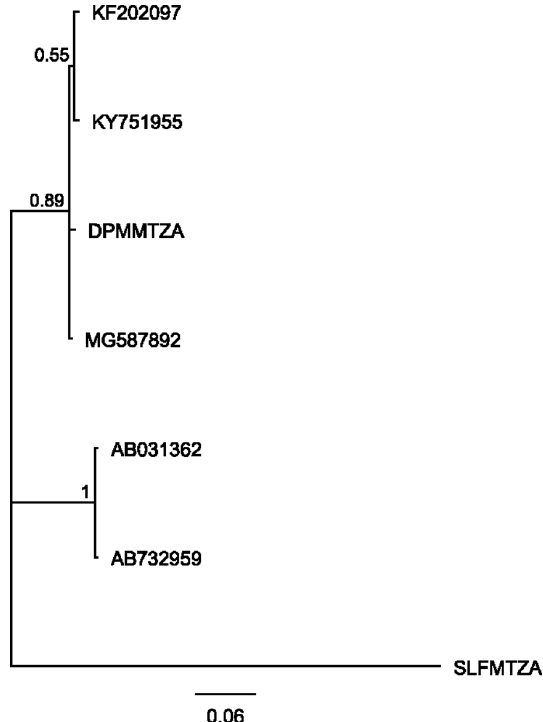
Figure 4. 12S mt rDNA tree obtained for D.caninum sequences from GenBank using Schistocephalus solidus as the